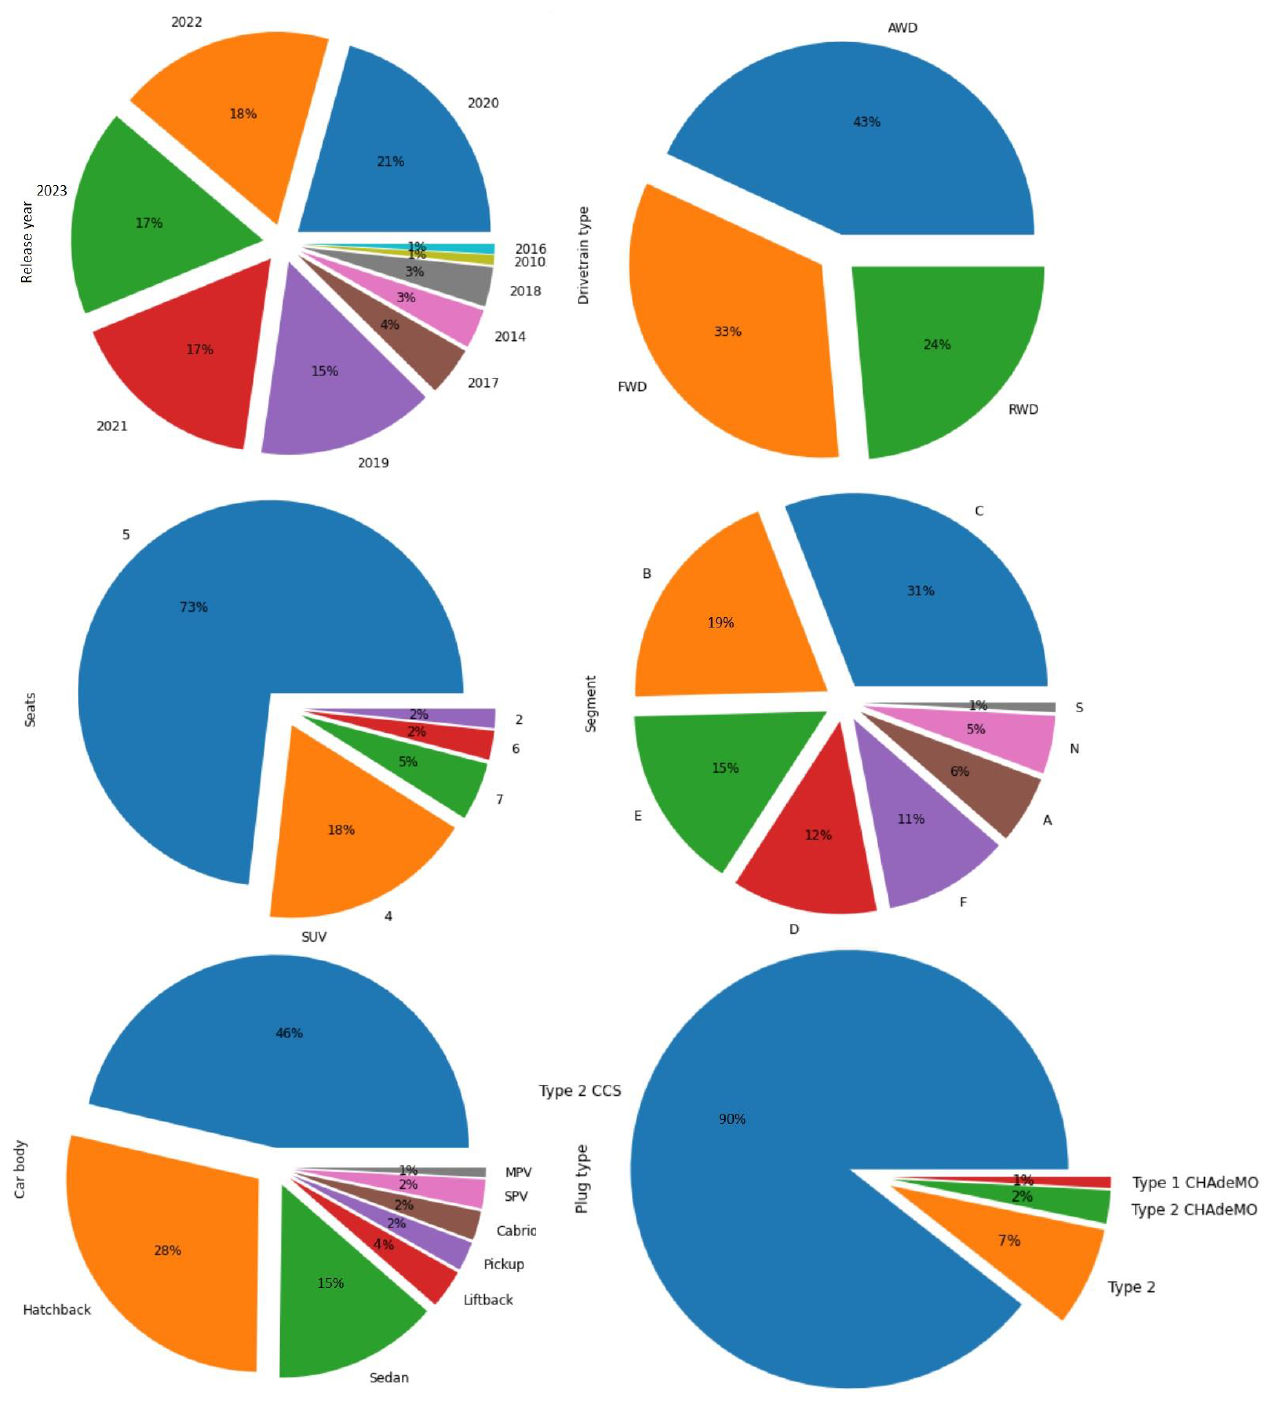
Figure 3. Selected pie charts of analyzed parameters of electric